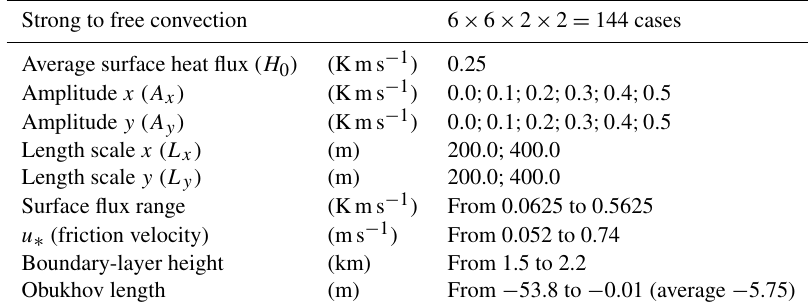
Table 3. Parameters of the simulations within the suite focusing on the landscape heterogeneity at hectometer scale. Strong to free convection 6 × 6 × 2 × 2 = 144 cases